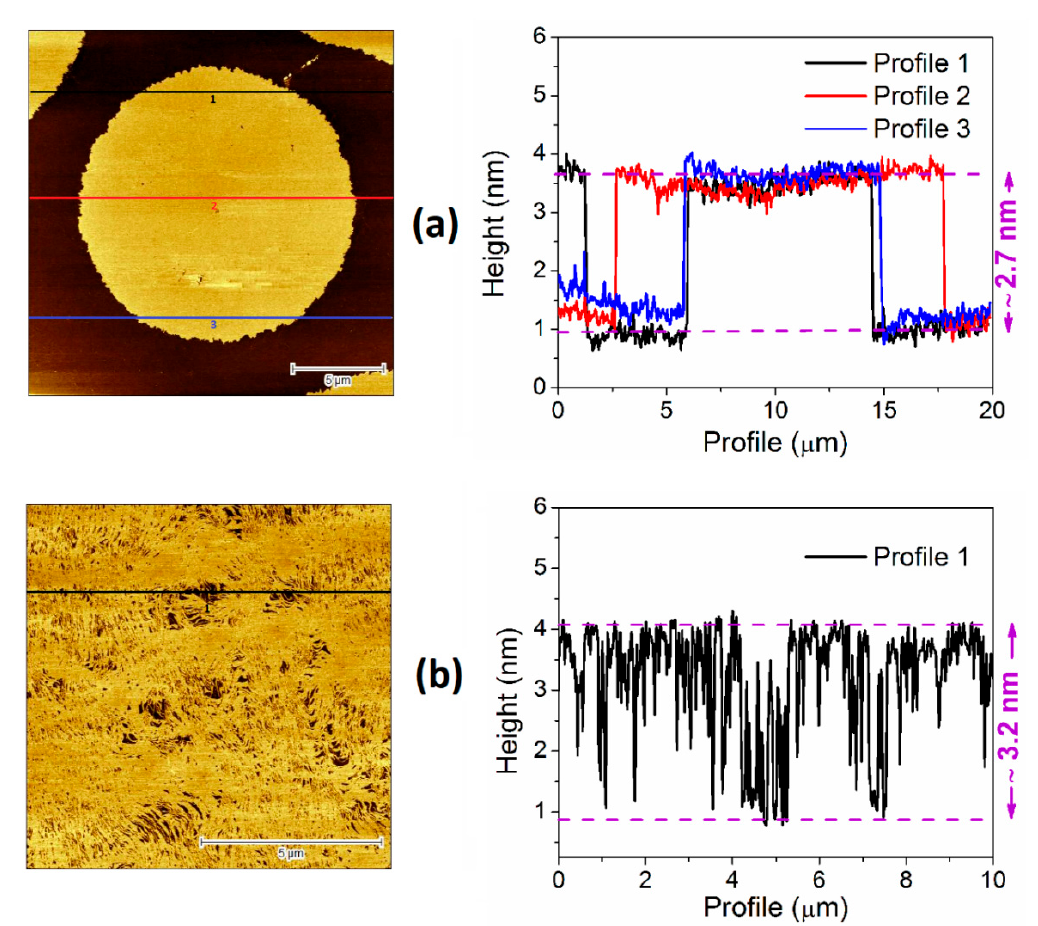
Figure 6. AFM height images (left) with the line profiles (right) of the LB film transferred at a π of 15 mN/m for ( a ) Ethoxy-PPE mN/m and ( b ) Methyl-PPE- co -decadiene.